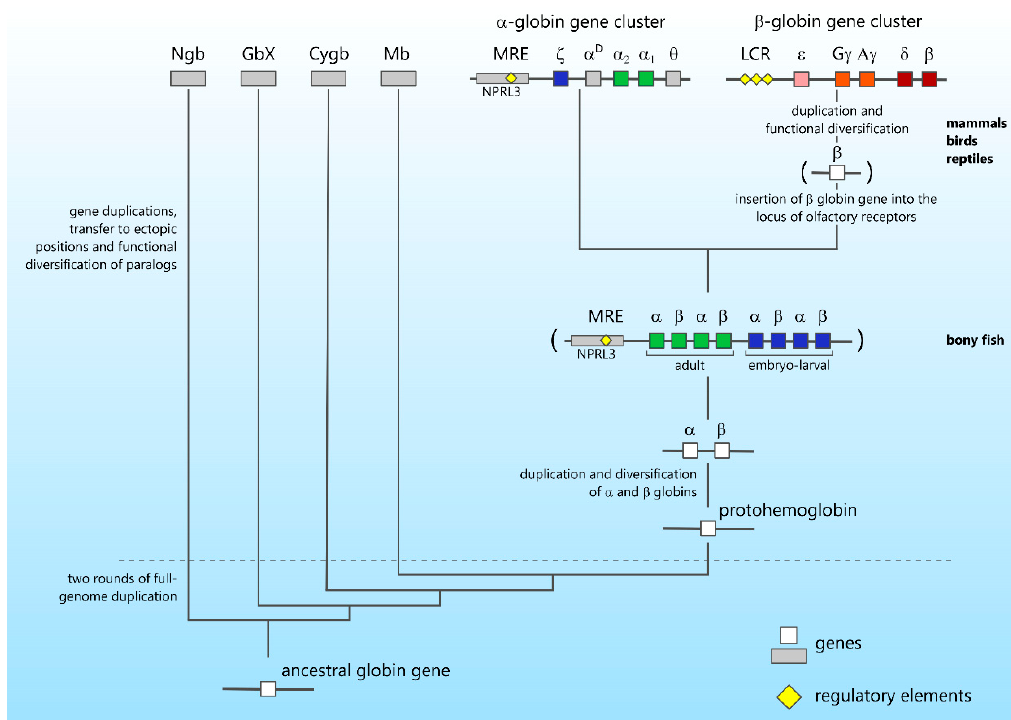
Figure 1. Main globin gene evolution stages. Clusters of human alpha- and beta-globin genes are shown at the top of the evolution tree. In the alpha-globin gene cluster, the colors of embryonal and adult globin genes show that these genes are homologs of embryonal and adult globin genes present in the ancestral cluster. The different color scheme for designation of embryonal ( ε ), fetal (G γ , A γ ), and adult ( δ , β ) globin genes in the beta-globin gene cluster is used to show that these genes are not homologs of embryonal and adult globin genes present in the ancestral cluster, but originated via duplication of a single beta-type globin gene transposed to a new genomic